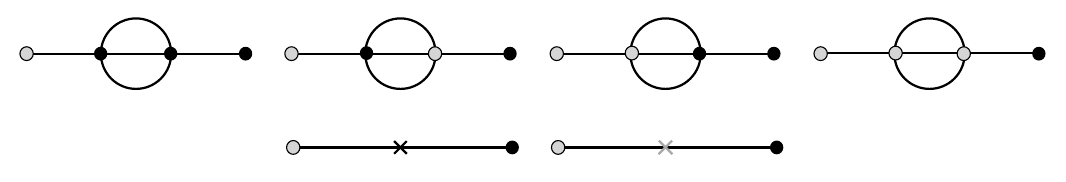
Figure 5 . (Top) Connected two-loop contributions of the ‘sunset’ type to the two-point correlation function in a λφ 4 theory. (Bottom) The corresponding δ m and/or δ r counterterm